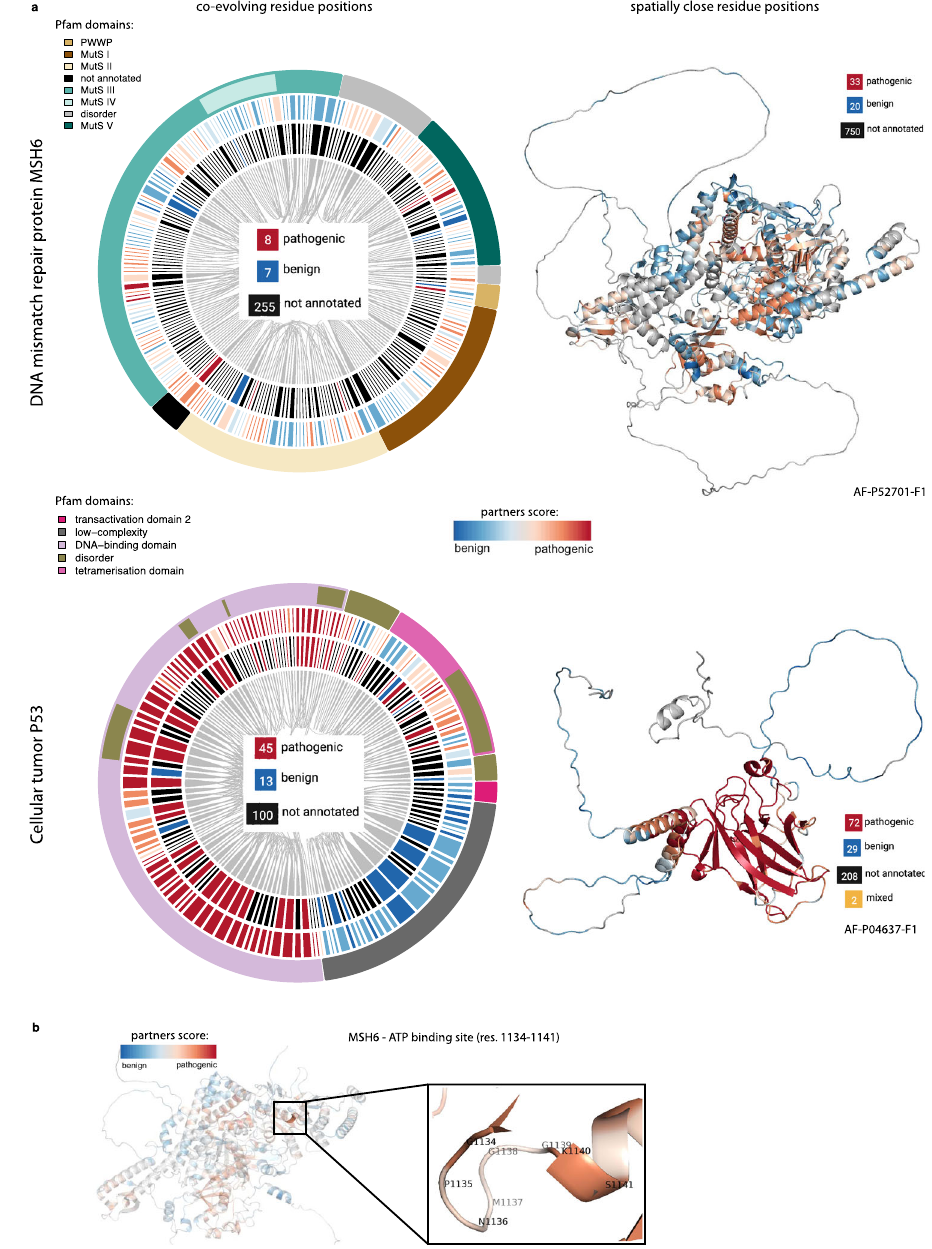
Fig.3|Thepartnersscoreannotatesresiduepositionslackingpriorfunctional orclinicalassessments.a Onthetopleft,co-evolvingresiduepositionsareshown fortheDNAmismatchrepairproteinMSH6.Theinnermostcircleindicatesresidues that are co-evolving with at least one other residue whose phenotypic effect is known(i.e.,annotatedinthetrainingset).Amongsuchresidues,8arepathogenic,7 benign, and 255 lack prior assessment. The outer circle shows the partners score resulting from co-evolutionary partnership of residues, which gives a score to 255 residue positions without known annotations. The outermost circle indicates the Pfam domains of MSH6.Onthe right, AlphaFold3Dmodel of the protein is shown. Residue positions are colored based on the partners score derived from spatially